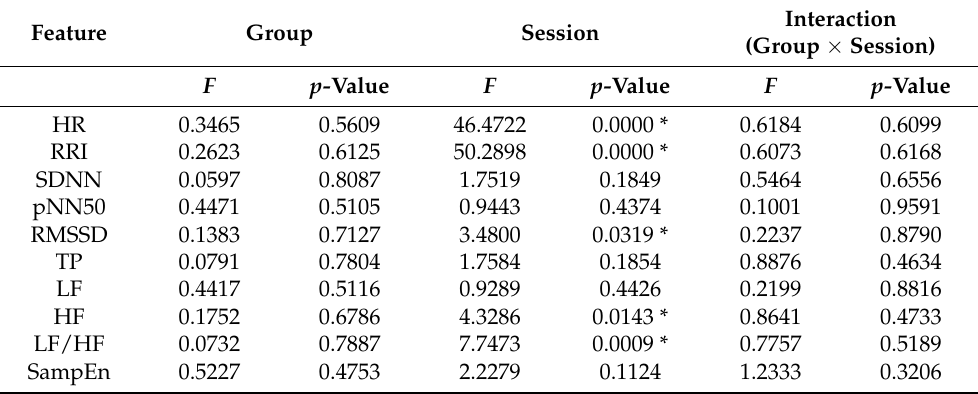
Table 4. Effects of group and session on ECG features.